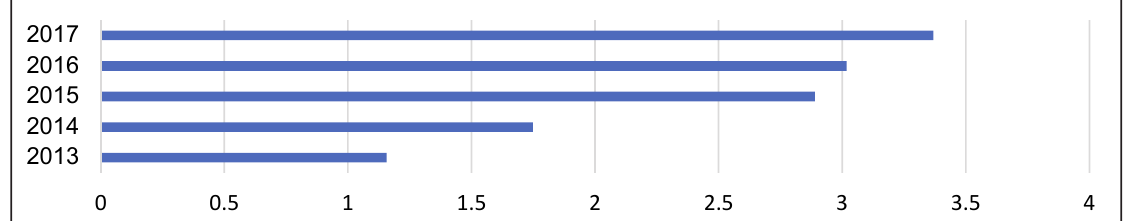
Fig. 1. Volatility of the index of disclosure of environmental accounting information of listed firms for the period 2013 – 2017